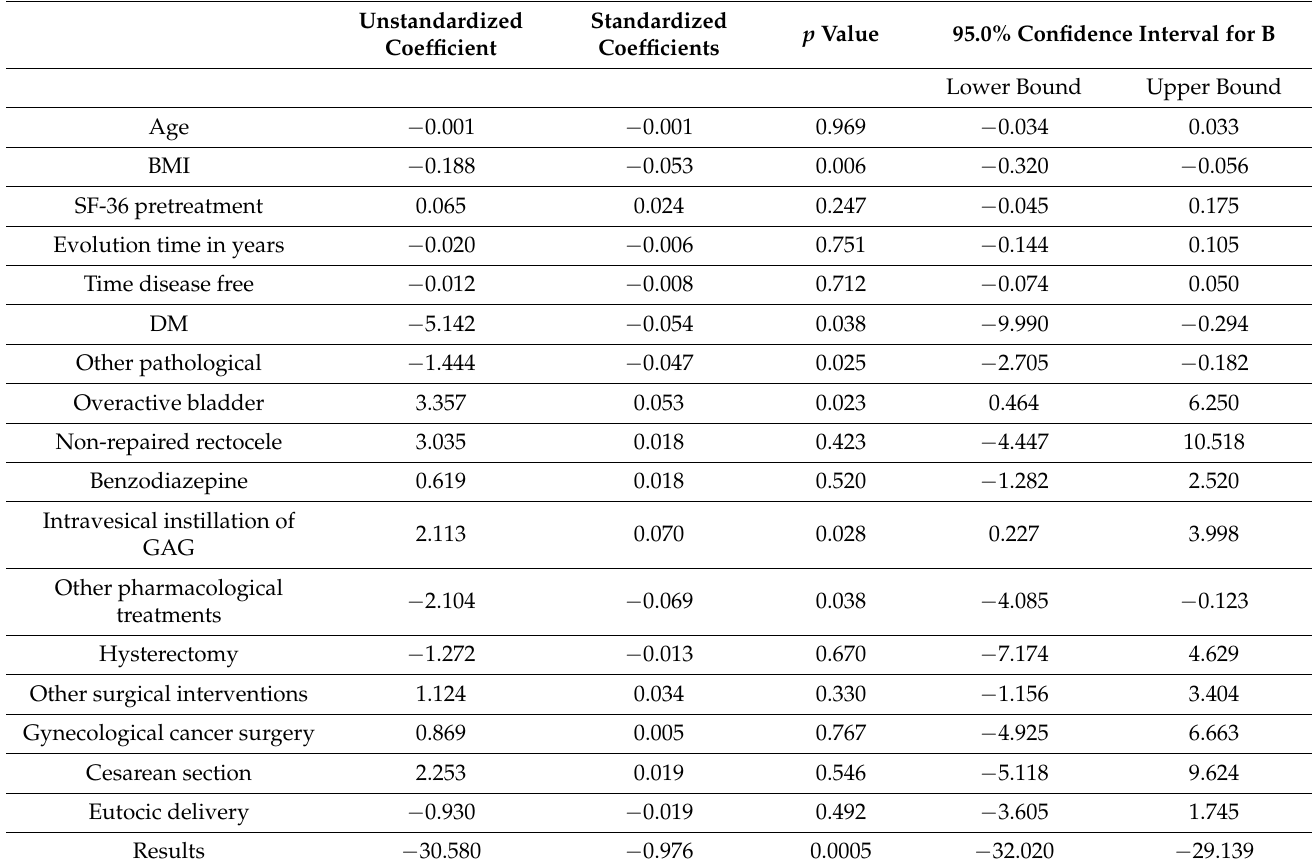
Table 4. Multiple regression analysis’ table: probability of quality of life’s improvement or worsening: relationship between the result in the SF-36 questionnaire post-treatment and the